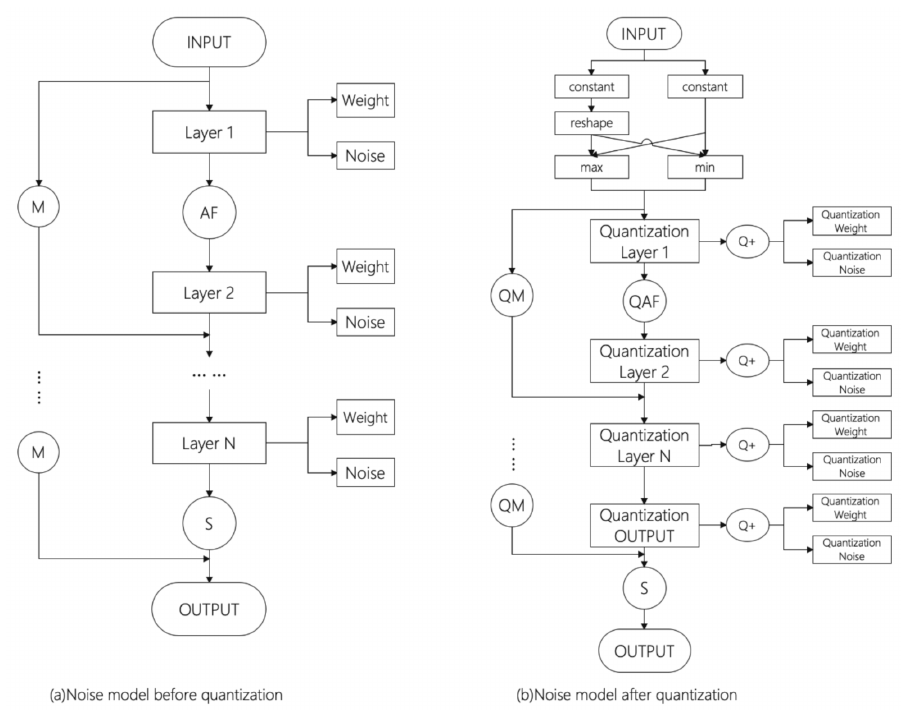
Figure 7. Model with noise ( a ) before and ( b ) after quantization. In Figure 7, M, QM, and S are the same means as Figure 6. Q+ represents quantiza- tion